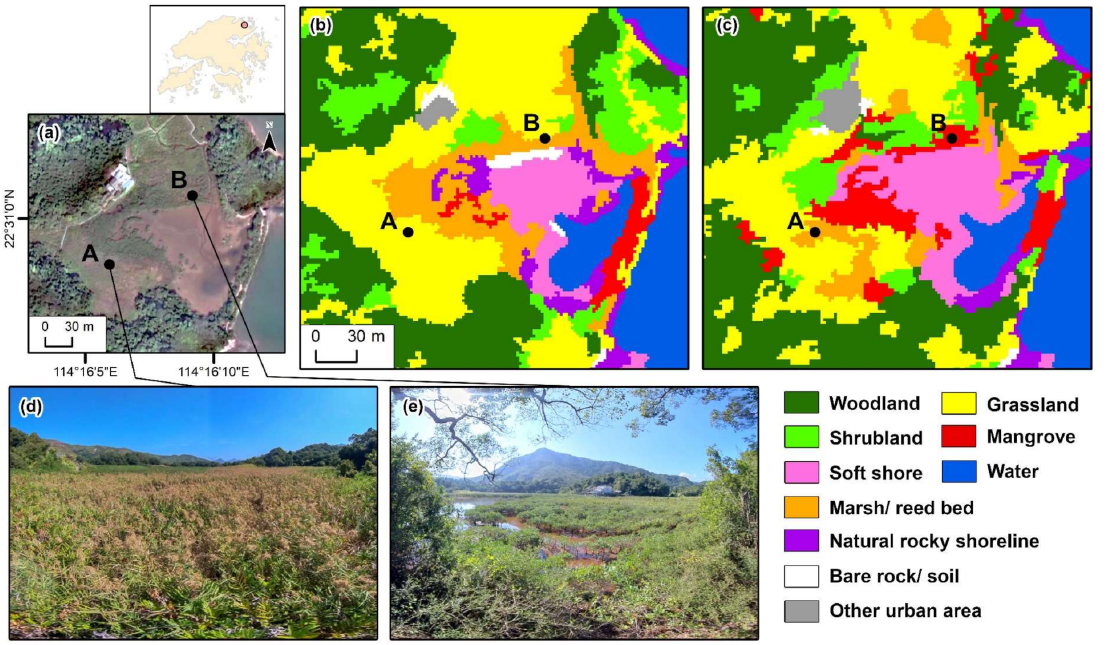
Figure 10. A selected wetland site including both marsh/ reed bed (Point A) and mangrove (Point B) habitats; ( a ) true-colour composite of the WorldView image; ( b ) classification result using pixel-based random forest (RF) method; ( c ) classification result using object-based support vector machine (SVM) method; ( d ) photo of point A taken in the field, which is covered mainly by Phragmites australis ; ( e ) photo of point B taken in the field, which is covered mainly by Kandelia obovata